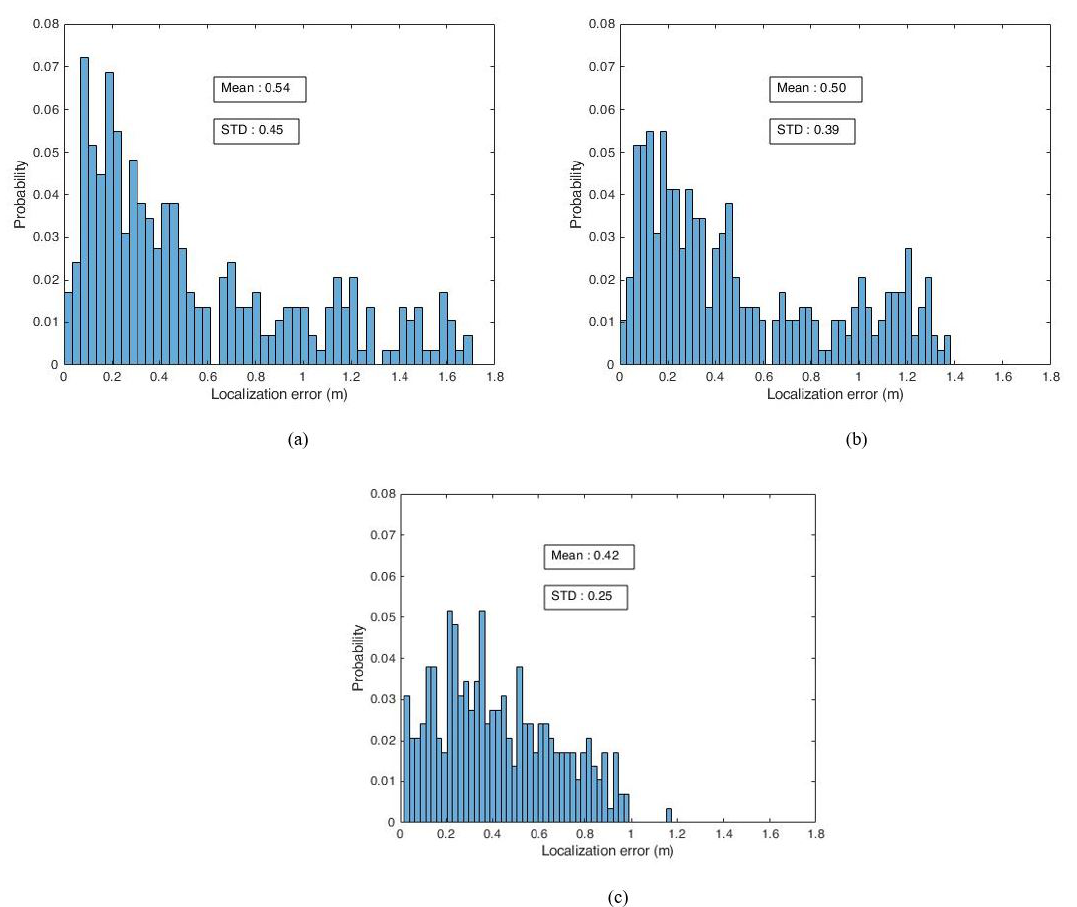
Figure 11. Probability distribution of the localization error for rectangular motion . ( a ) PDR+Wi-Fi trilateration. ( b ) PDR+Wi-Fi fingerprint. ( c ) Proposed Sensor Fusion